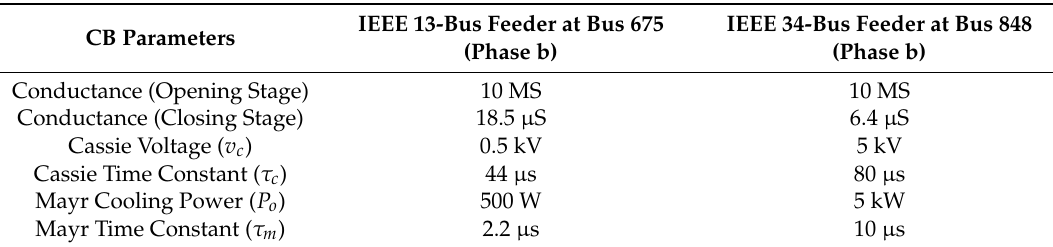
Table 2. Circuit breaker (CB)